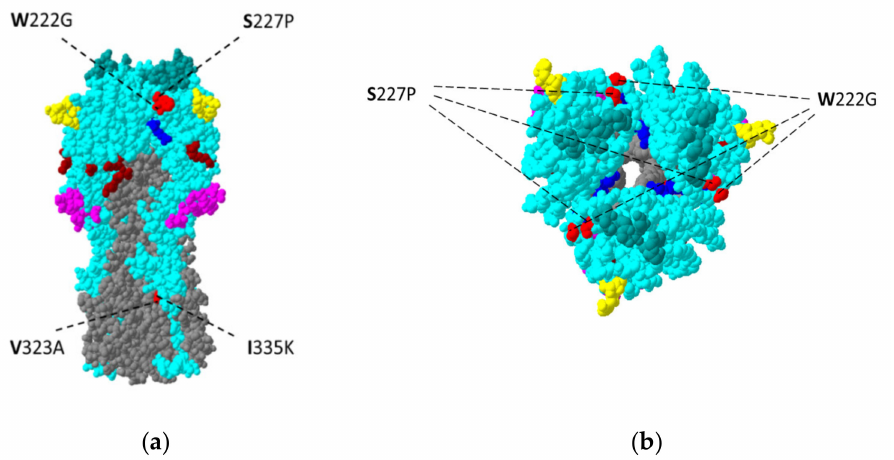
Figure 2. Single nucleotide variants (red) detected in the hemagglutinin protein of the A/equine/Pulawy/1/2005 (H3N8) strain during passages in embryonated chicken eggs. Regions of hemagglutinin are distinguished by color: teal—HA1; gray—HA2; as are five antigenic sites: yellow—antigenic site A; green—antigenic site B; pink—antigenic site C; dark blue—antigenic site D; and brown—antigenic site E. ( a ) Side view; ( b ) top view. The three-dimensional model is based on the crystal structure of A/equine/Richmond/1/2007 (H3N8) HA (PDB accession no. 4UO0) and visualized using Swiss-PdbViewer 4.1.0. [25].